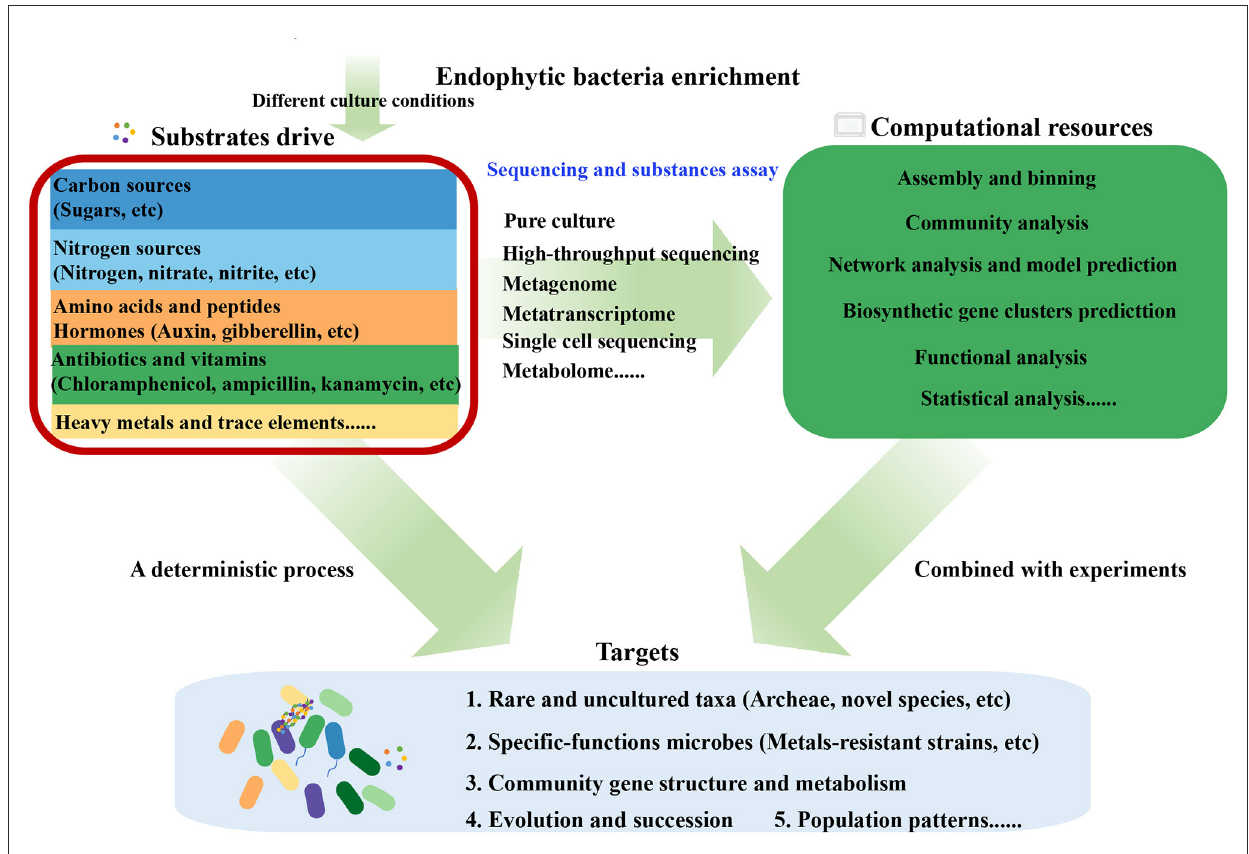
FIGURE7 The outline of various substrate-based approaches to investigate the composition, function, correlation, and metabolism of plant endophytic microbial communities.